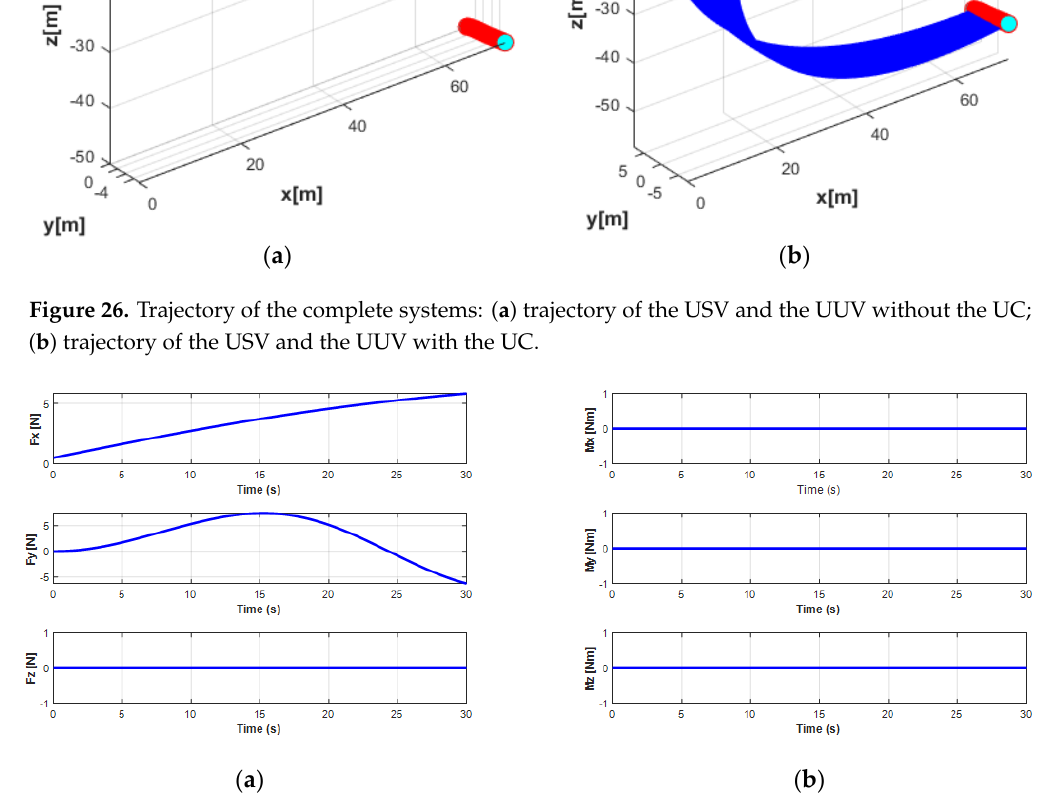
Figure 27. Cable forces and moments effecting to the USV doing the forward motion: ( a ) forces of the UC on the USV; ( b ) moments of the UC on the USV.